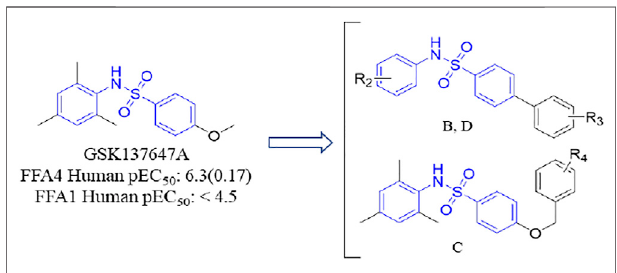
FIGURE 3 | The design strategy of GPR120 small-molecule